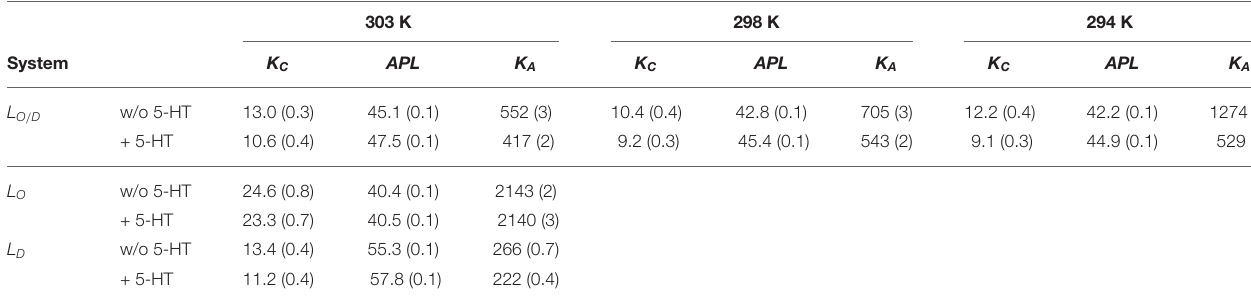
TABLE 4 | Averaged physical properties of the membrane in the different systems: bending constant ( K C [10 − 20 J ]), area per lipid ( APL [ 2 ]), and lipid area compressibility ( K A [mN/m]). Standard errors are given in parenthesis. 303